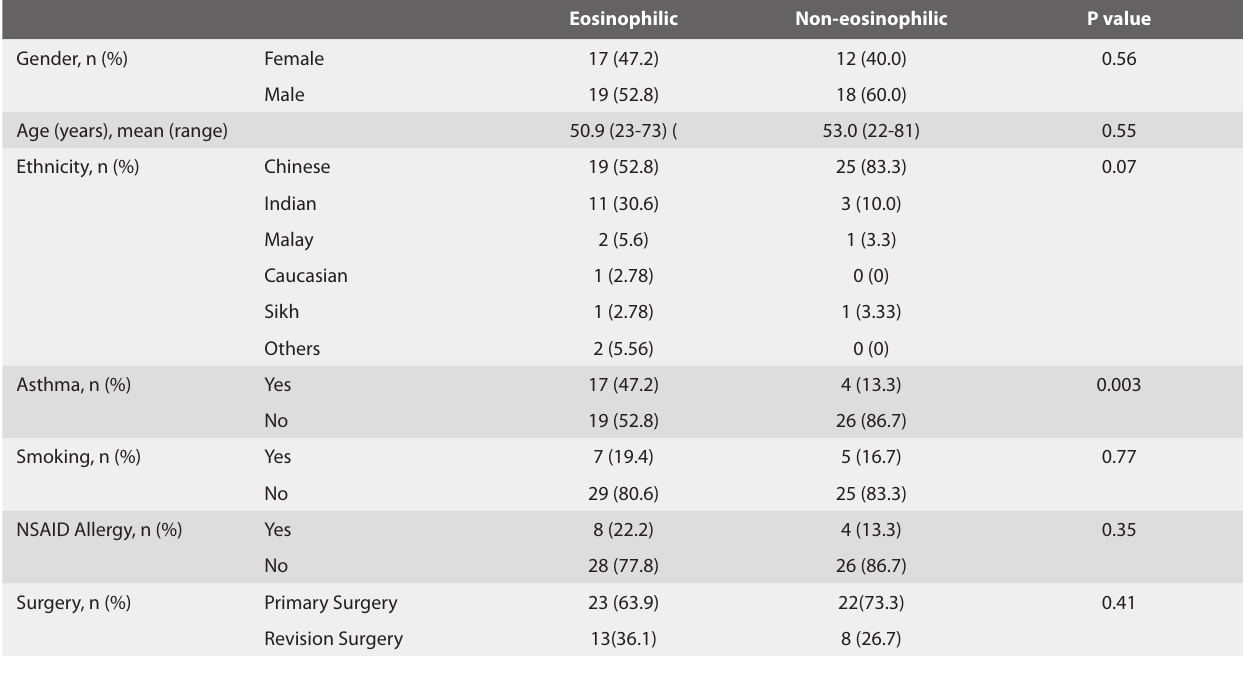
Table 1. Demographic